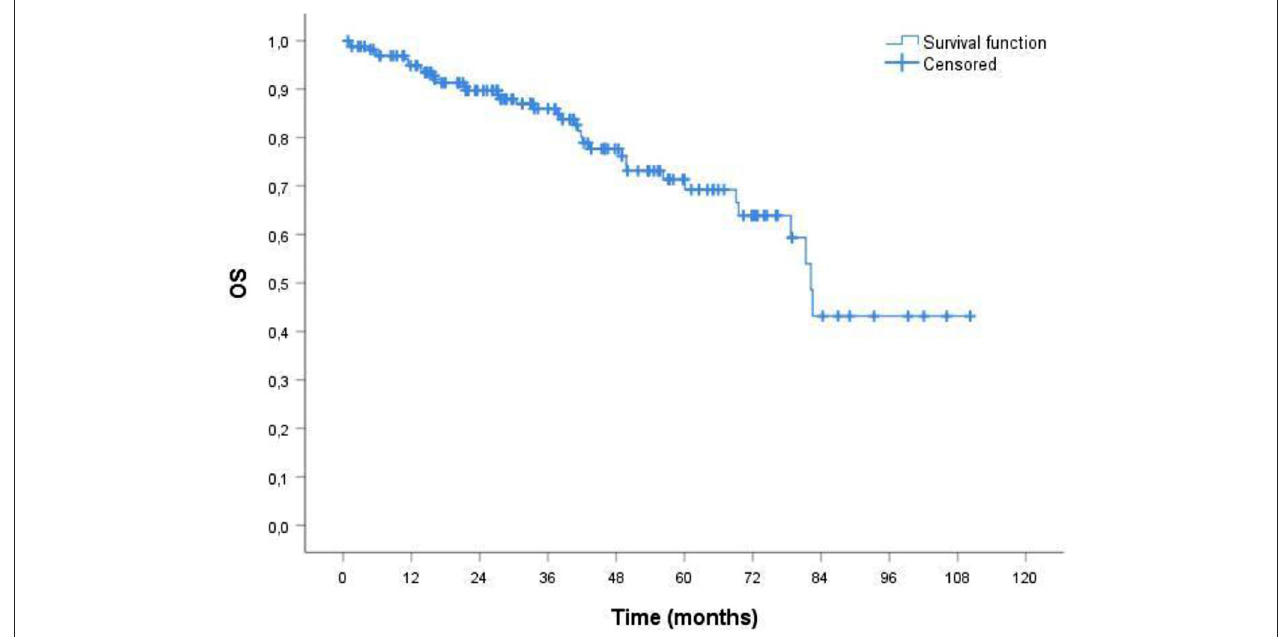
FIGURE 1 | Probability of overall survival (OS) by Kaplan-Meier estimates in patients with MM treated with VMP (total patients 164). The median OS was 34.33 mo. VMP, bortezomib plus melphalan-prednisone.